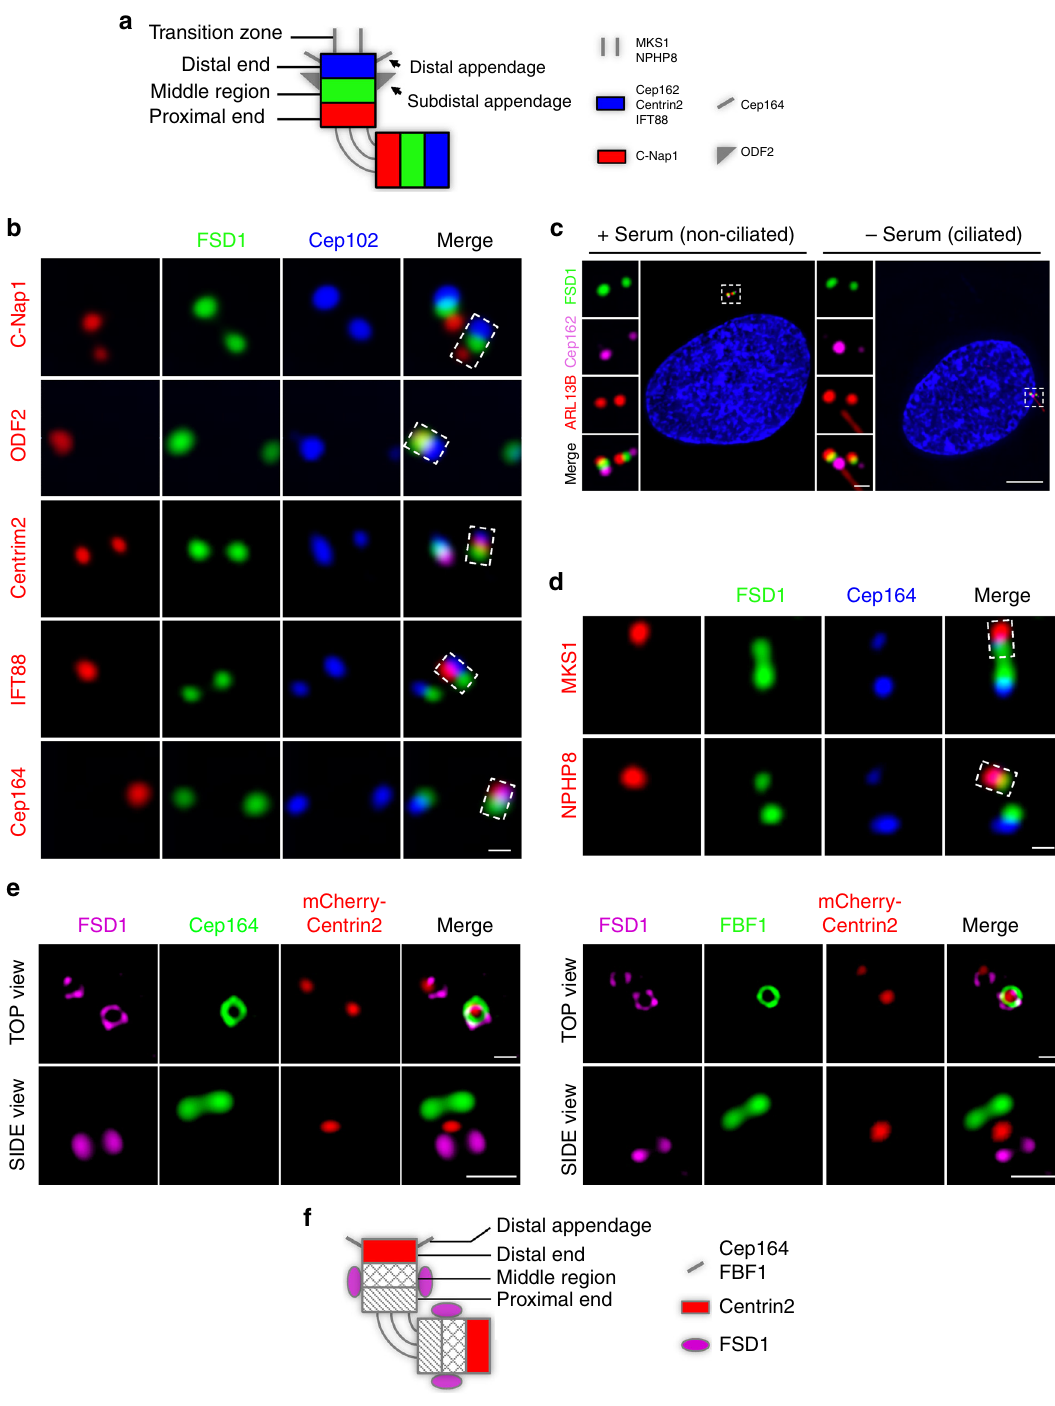
Fig. 3 FSD1 forms a ring structure at the subdistal region of both centrioles. a Schematic of centrosome structure. The centrosome is composed of a pair of centrioles, and each centriole is divided into three portions, including proximal end (red), middle region (green), and distal end (blue). The older centriole of the pair (the mother) is often decorated with distal appendages and subdistal appendages. During ciliogenesis, the transition zone extends from the distal end of the mother centriole. b FSD1 was visualized with centriolar proximal (C-Nap1), distal (Cep162, Centrin2, and IFT88), subdistal appendage (ODF2), and distal appendage (Cep164) markers. ODF2, IFT88, and Cep164 localize to mother centrioles. Scale bar, 500 nm. c The centriolar localization of FSD1 was observed in ciliated and non-ciliated cells stained with indicated antibodies. Cep162, the centriole distal end marker. ARL13B, the primary cilia marker. Scale bars, 5 μ m (main image) and 500 nm (magni fi ed region). d The centriolar localization of FSD1 was observed in ciliated cells stained with indicated antibodies. Cep162, the centriole distal end marker. MKS1 and NPHP8, the ciliary transition zone markers. Scale bar, 500 nm. e RPE-1 cells were transfected with mCherry-Centrin2 plasmids and stained with the indicated antibodies. The samples were then imaged using the stimulated emission depletion microscopy (STED). Cep164 and FBF1 localize to the distal appendage of mother centrioles. Scale bars, 500 nm. f Schematic representation of the centrosome illustrates that FSD1 forms a ring structure at the middle region encircling both